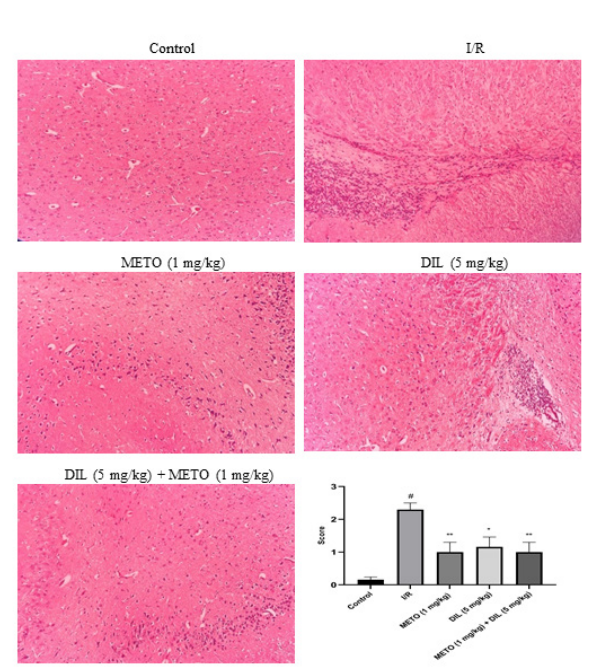
FIGURE 2 - (A) Photomicrographs of brain stained with H&E after cerebral ischemia/reperfusion; (B) Grading of histopathological changes in the rat ’ s brain tissues. Data are expressed as mean±S.E.M. N=6. # P<0.001 vs control group. ** P<0.01, * P<0.05, and ** P<0.01, respectively, vs. I/R group using one-way ANOVA with Tukey post-test. I/R: Ischemia/ reperfusion; METO: Metoprolol; DIL: Diltiazem.